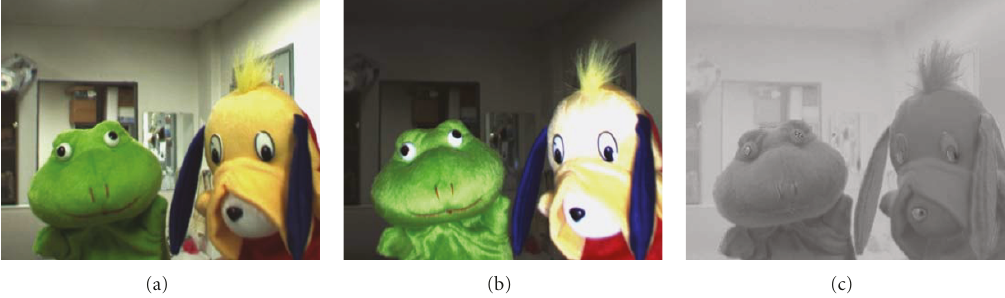
Figure 3: (a) Unlit frame, (b) lit frame, and (c) the sensitivity